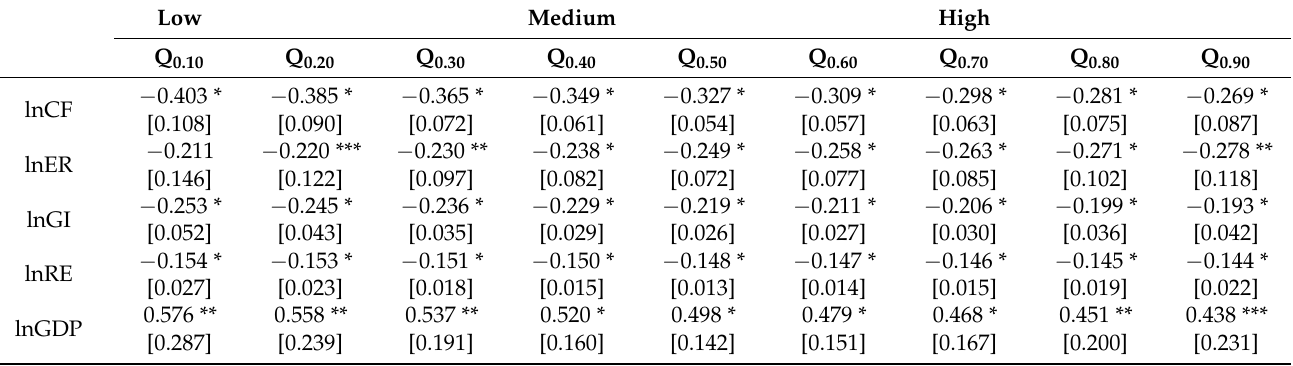
Table 8. MM-QR regression